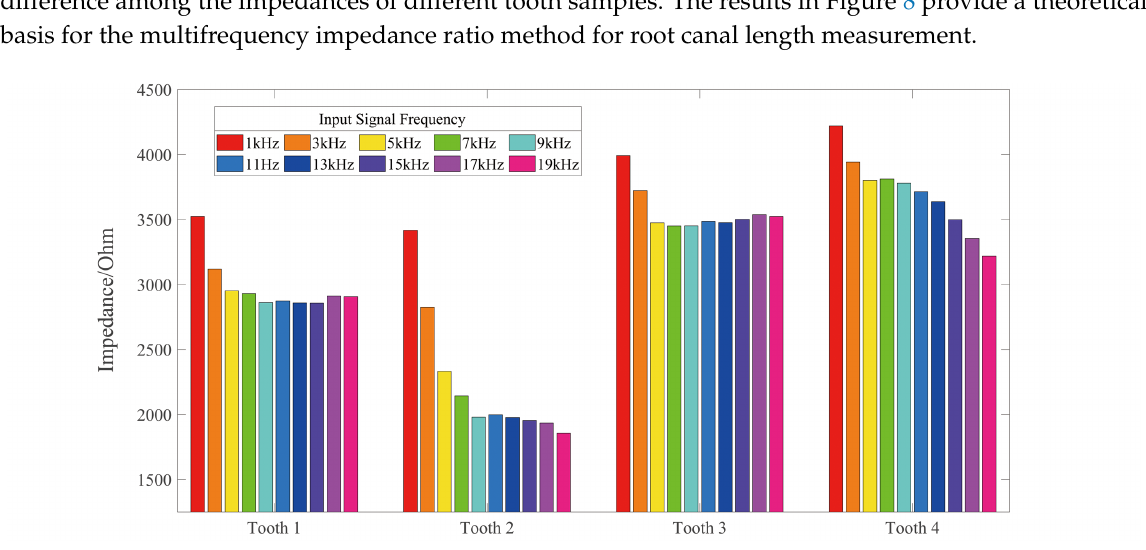
Figure 7. The impedance of different input signal frequencies varying with the tooth